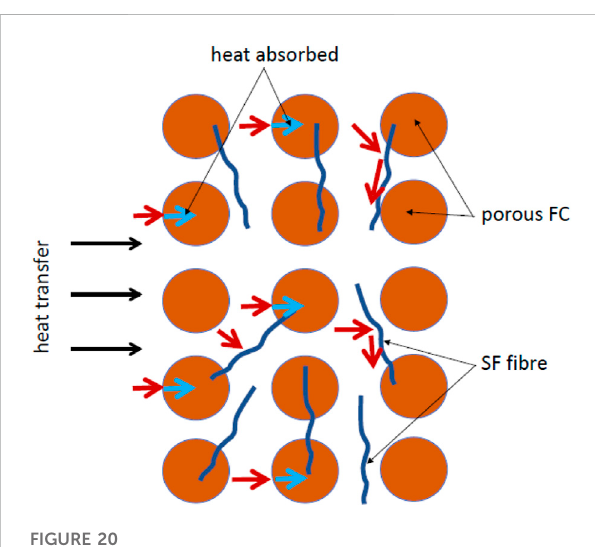
FIGURE 20 Porous nature of FC with the presence of SF allows heat to be